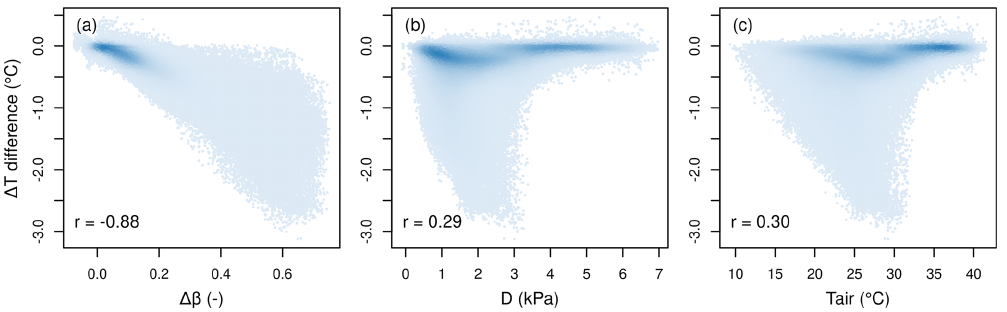
Figure 8. Density scatter plots showing the three factors that influence the difference in T canopy − T air between GW and FD ( (cid:49)T , expressed as GW–FD difference). Panel (a) is (cid:49)T difference against the β difference (GW–FD) ( (cid:49)β ), (b) is (cid:49)T difference against vapour pressure deficit ( D ), and (c) is (cid:49)T difference against T air . Each point corresponds to a tree pixel on a heatwave day in January 2019. The darker colours illustrate where the records are denser. The correlation ( r ) between the x and y axes is shown in the bottom left of each